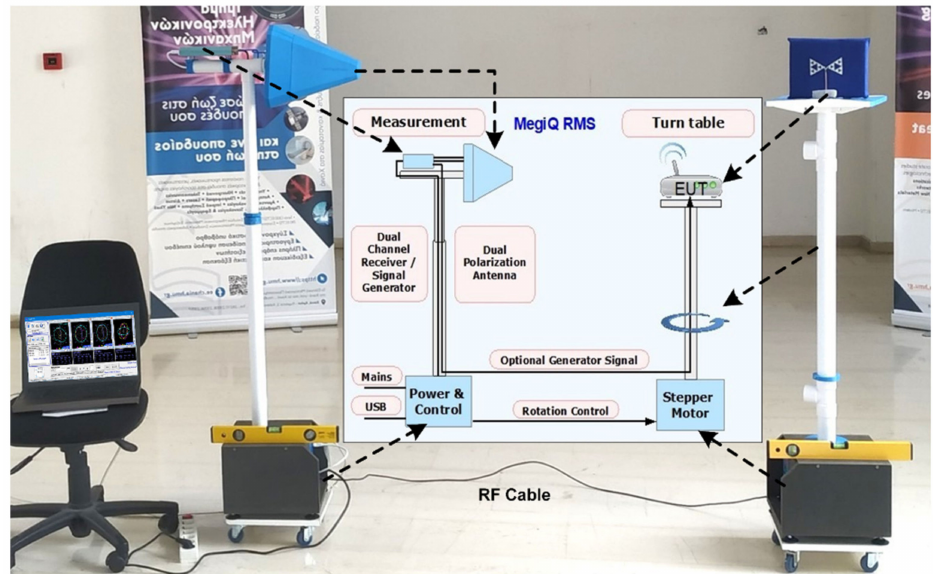
Figure 8. Measurement setup of the radiation